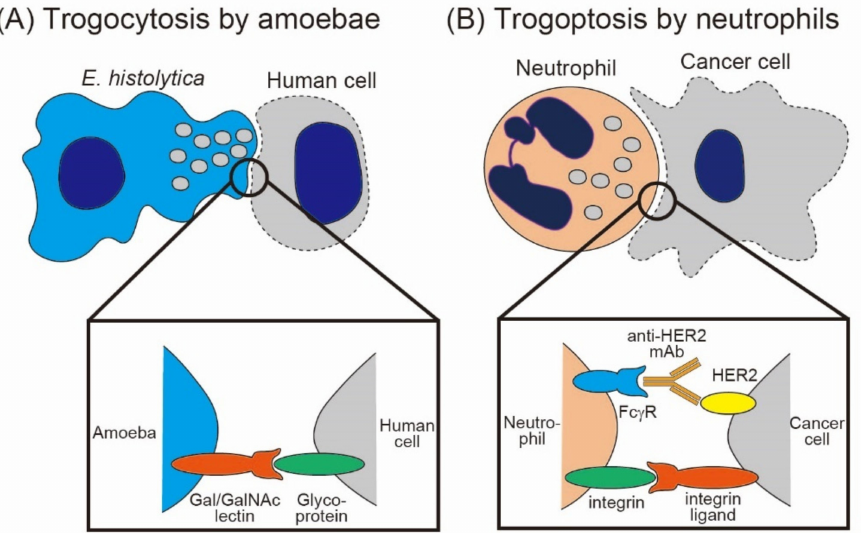
Figure 2. Trogocytosis-mediated cell death by amoebae and neutrophils. ( A ) Amoebae nibble human cells via trogocytosis, leading to the death of human cells. The interaction between amoe- bae and human cells is dependent on Gal/GalNAc lectin expressed on amoebae; ( B ) neutrophils nibble antibody-opsonized cancer cells via trogocytosis, resulting in cancer cell death (a process called trogoptosis). Trogoptosis by neutrophils is dependent on Fc γ R and Mac-1 integrin expressed on